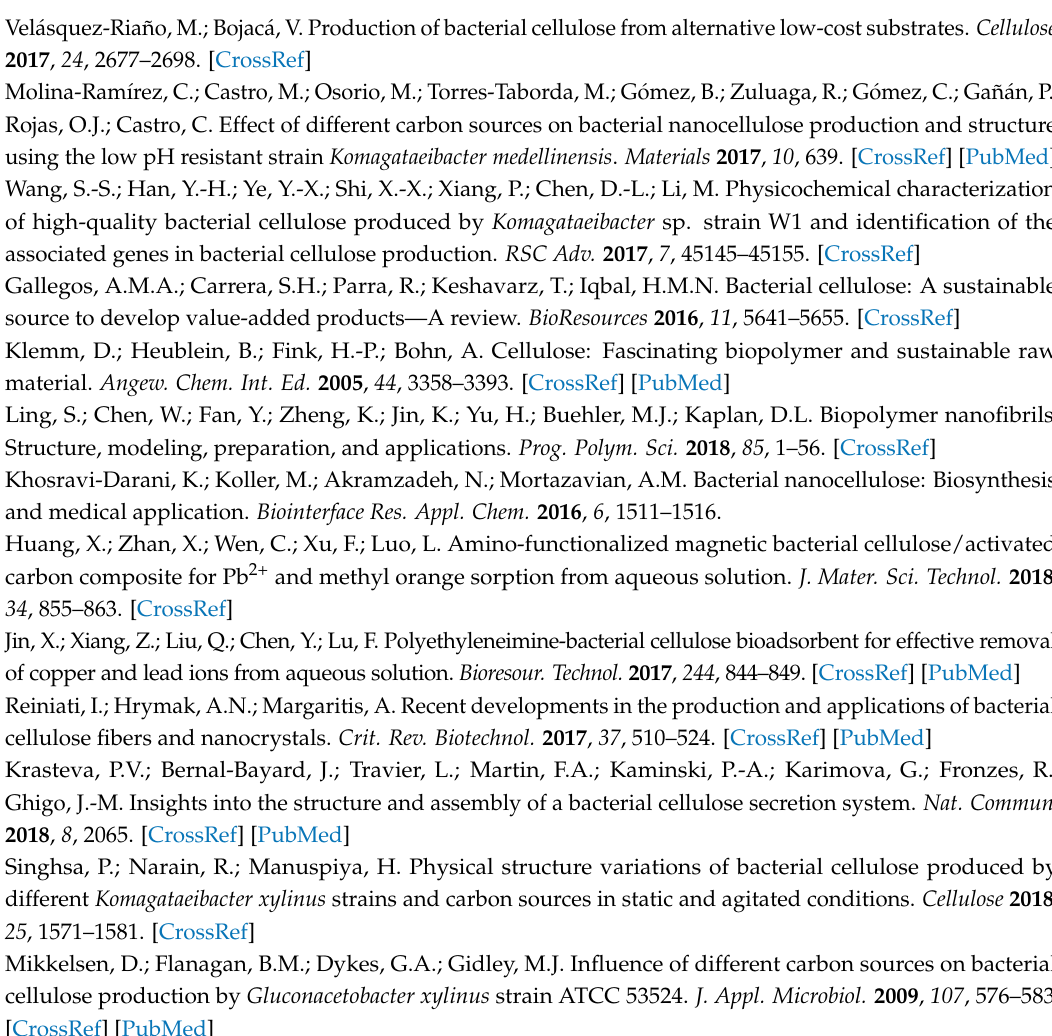
Figure S1: Structures of various carbon sources (A–H) and bacterial cellulose (I), Table S1: Open reading frames and corresponding proteins information based on NCBI non-redundant protein (Nr) and Swissprot annotations, Table S2: Open reading frames and corresponding proteins information based on KEGG pathway